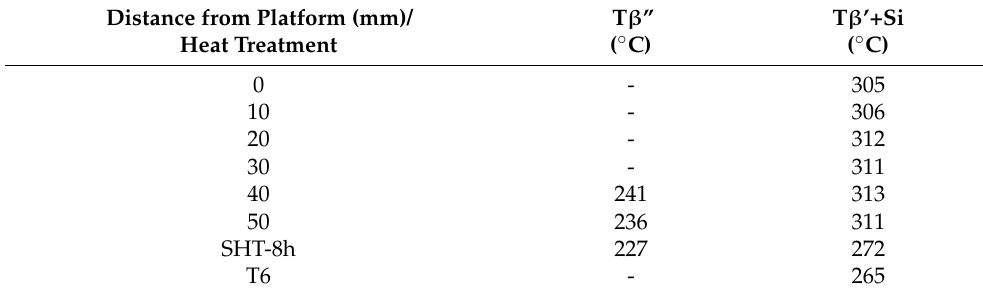
Table 5. Precipitation peak temperatures as a function of building height and heat treatment (area 2). Distance from Platform